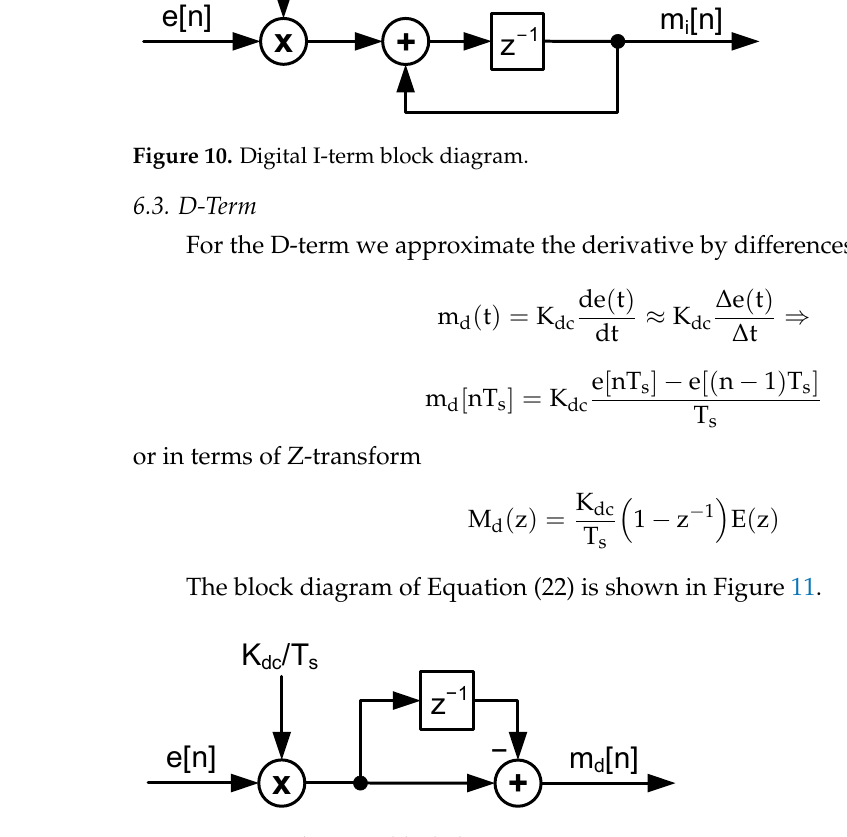
Figure 11. Digital D-term block diagram.